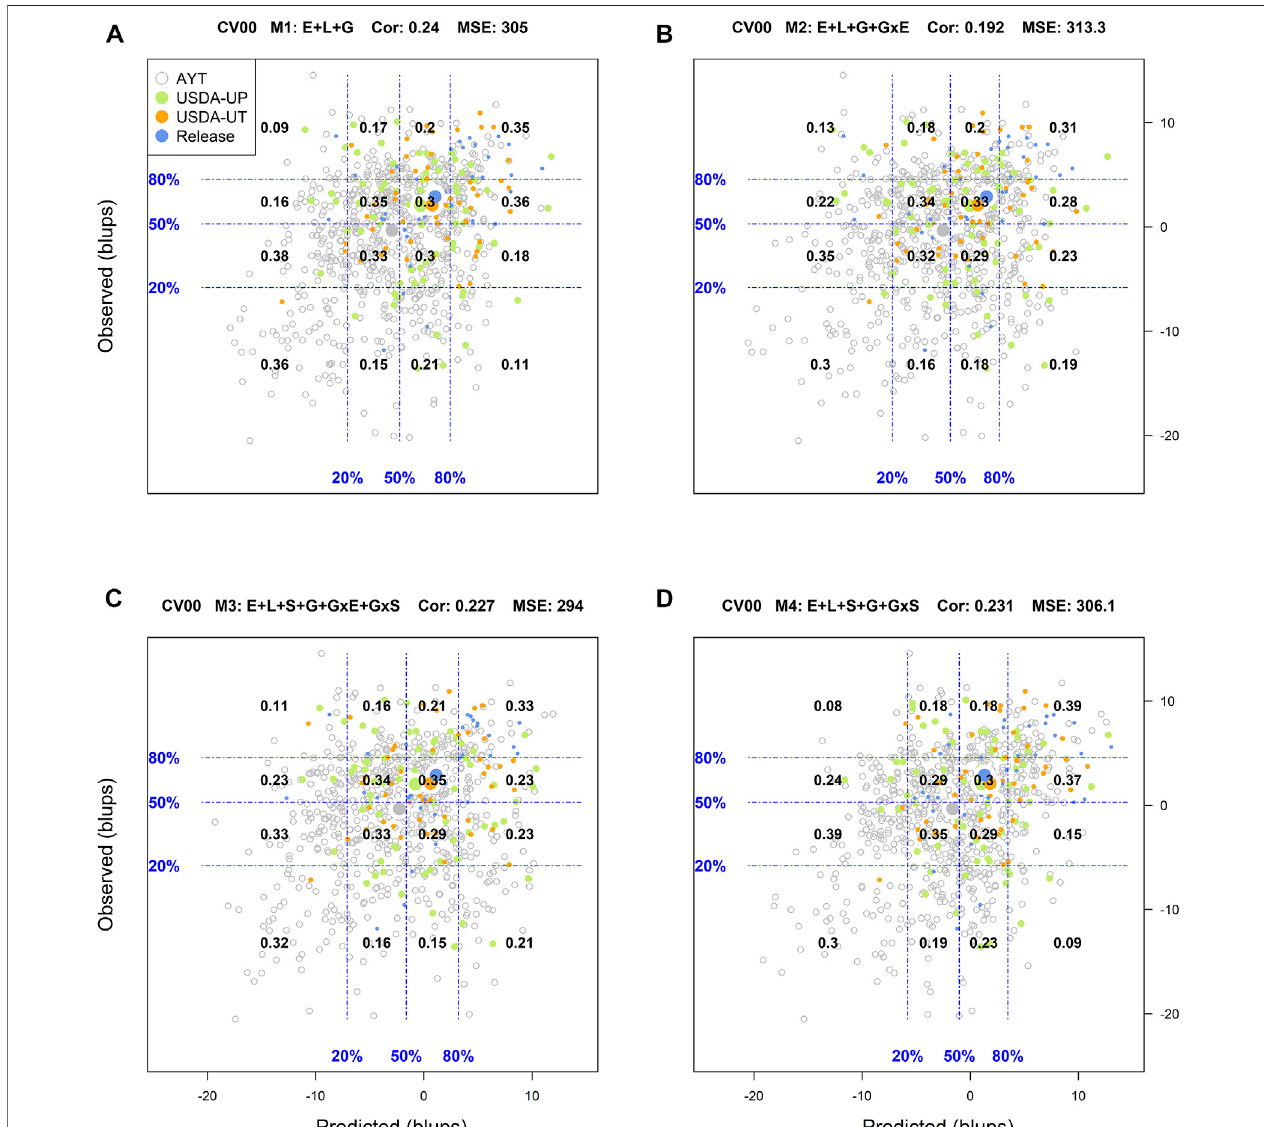
FIGURE 4 | Genotypic means (BLUP-centered on zero within environments) of observed versus predicted cross-validation predictions of four models (M1 – M4) under the cross-validation scheme CV00, which mimics the prediction scenario of predicting newly developed lines in novel environments (predicting untested genotypes in unobserved environments). Models and terms are described in detail in the Materials and Methods section ( Eqs 1 – 4 ). Horizontal and vertical dashed lines indicate the 20, 50, and 80% empirical percentiles corresponding to the observed and predicted values; the numbers inside the grid provide the conditional proportions observed on the y -axis for the different percentiles on the x -axis (e.g., out of the top 20% of the predicted values with M4 (panel D), 39% [top right] of these correspond to phenotypes that showed a performance among the 20% in fi